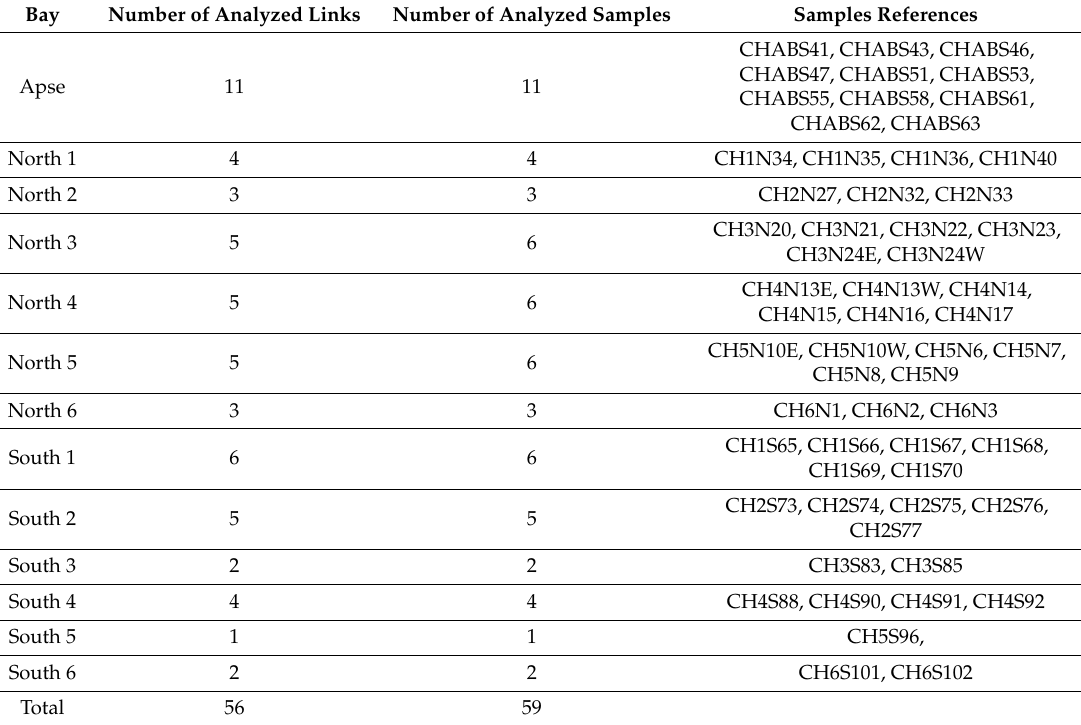
Table 1. Samples of the iron chain.